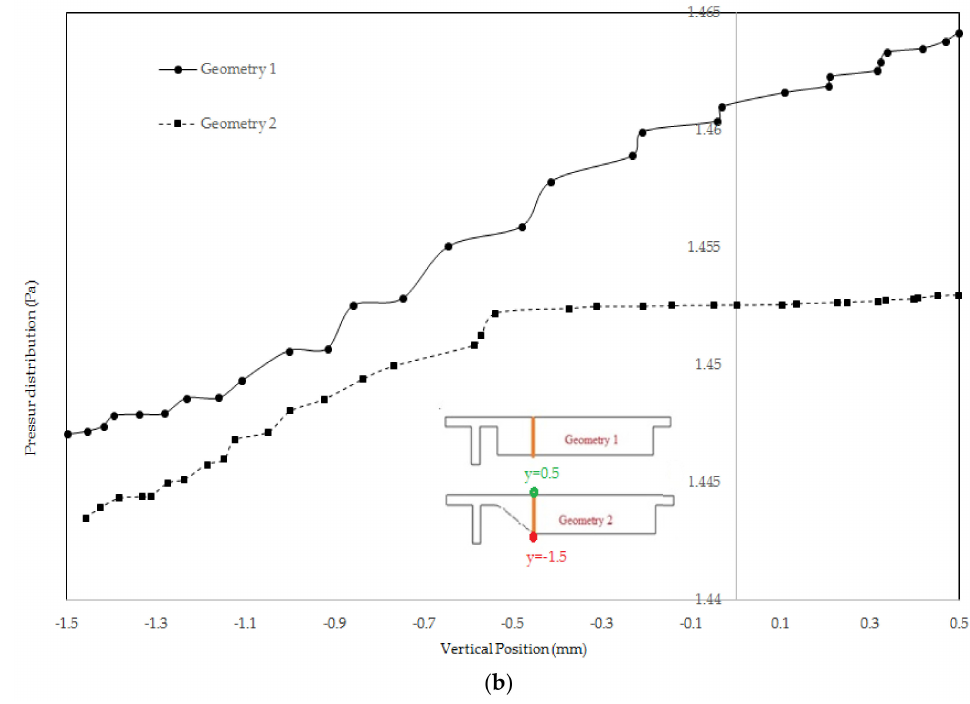
Figure 10. Pressure at specified cross section; the cross sections are determined to be: ( a ) at the beginning of the diverging section; and ( b ) at the immediate end of diverging section.